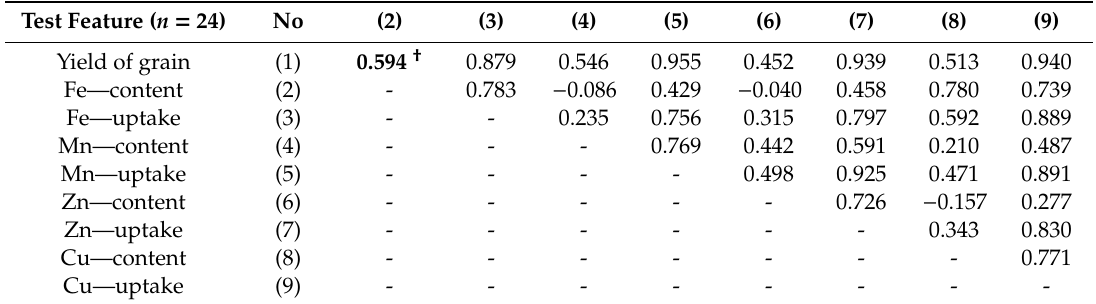
Table 7. Correlation coe ffi cients between grain yield and the content and uptake of micronutrients. Test Feature ( n =